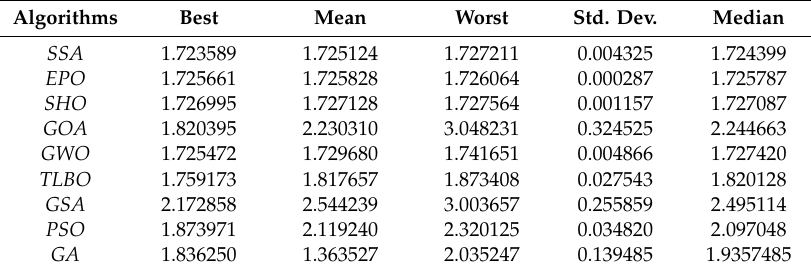
Table 10. Statistical results for welded beam design problem.